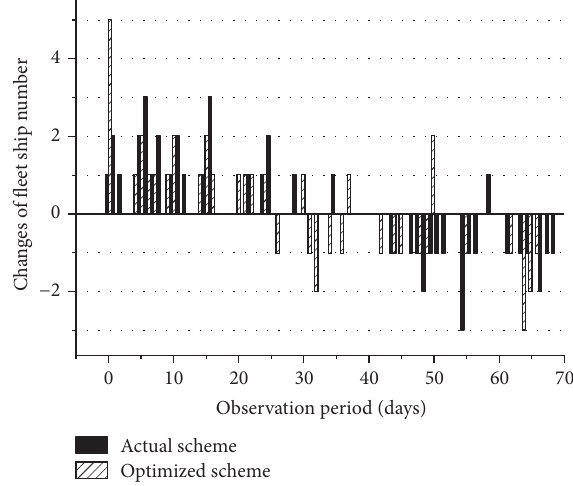
Figure 7: Comparative analysis of ships in waiting status.